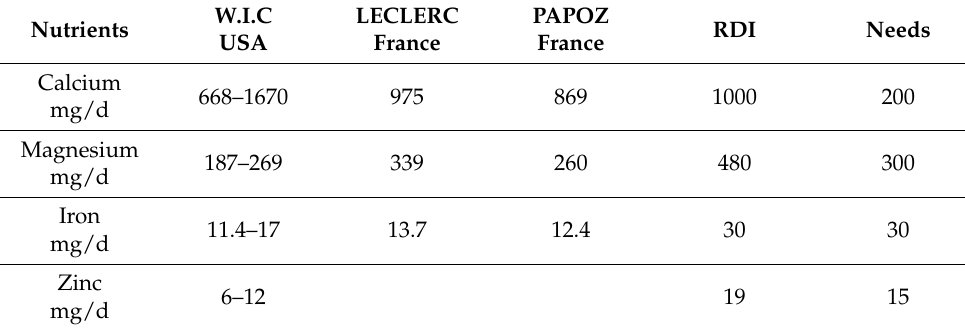
Table 4. Surveys minerals